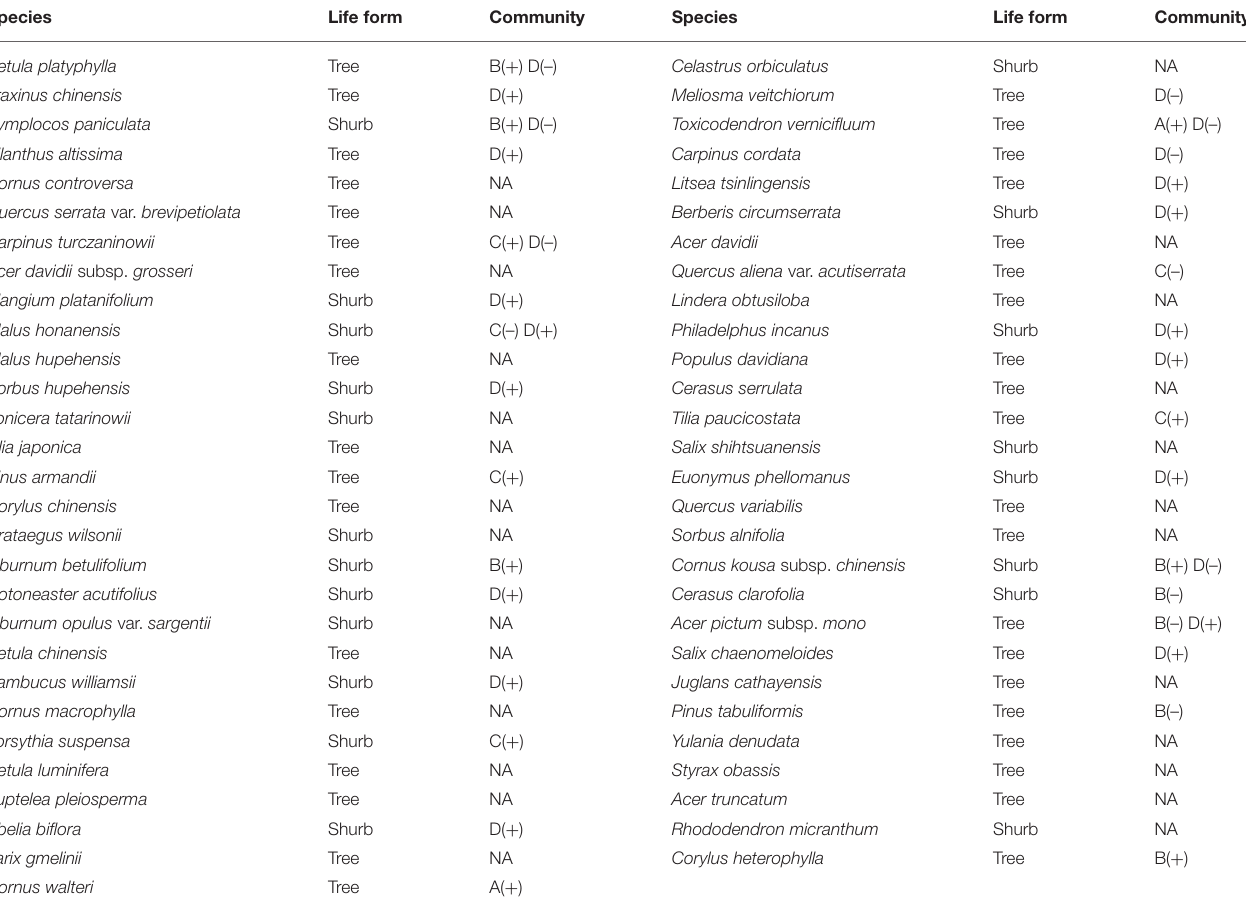
TABLE 3 | Significant associations of woody plant species with the four communities ( P ≤ 0.05 level of significance for torus-translation test).